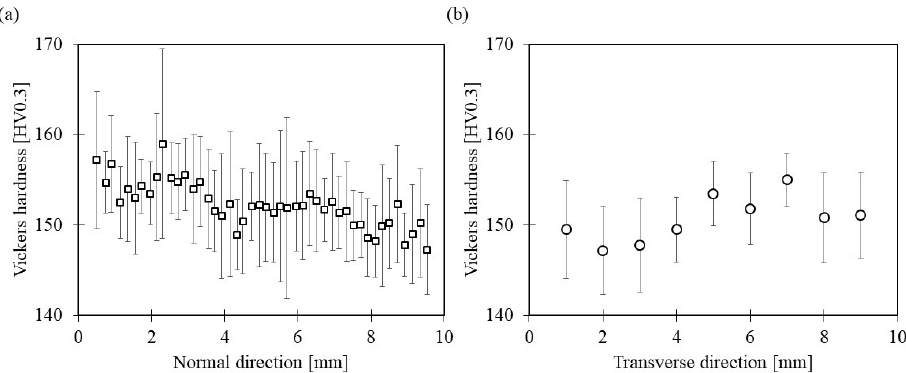
Figure 15. Microhardness distribution of WAAM-fabricated S355JR steel in ( a ) normal direction and ( b ) transverse